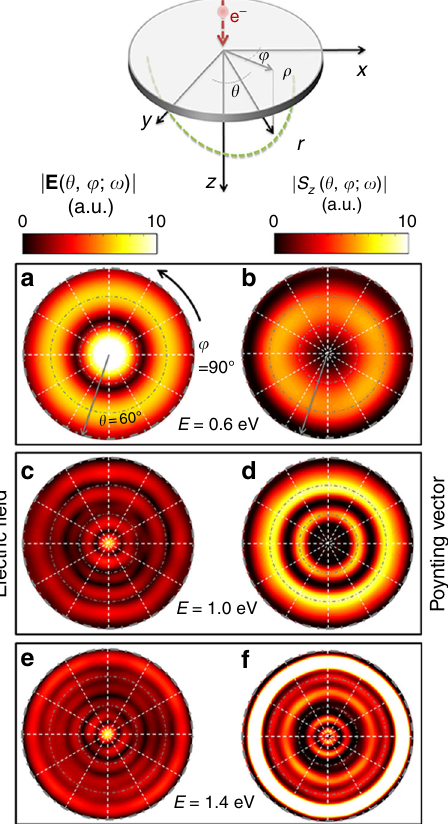
Fig. 4 Simulated k -space characteristics of electron-induced radiation at the focal plane. a , c , e Amplitude of the electric fi eld and b , d , f Poynting vector (corresponding to angular CL pro fi le) at different